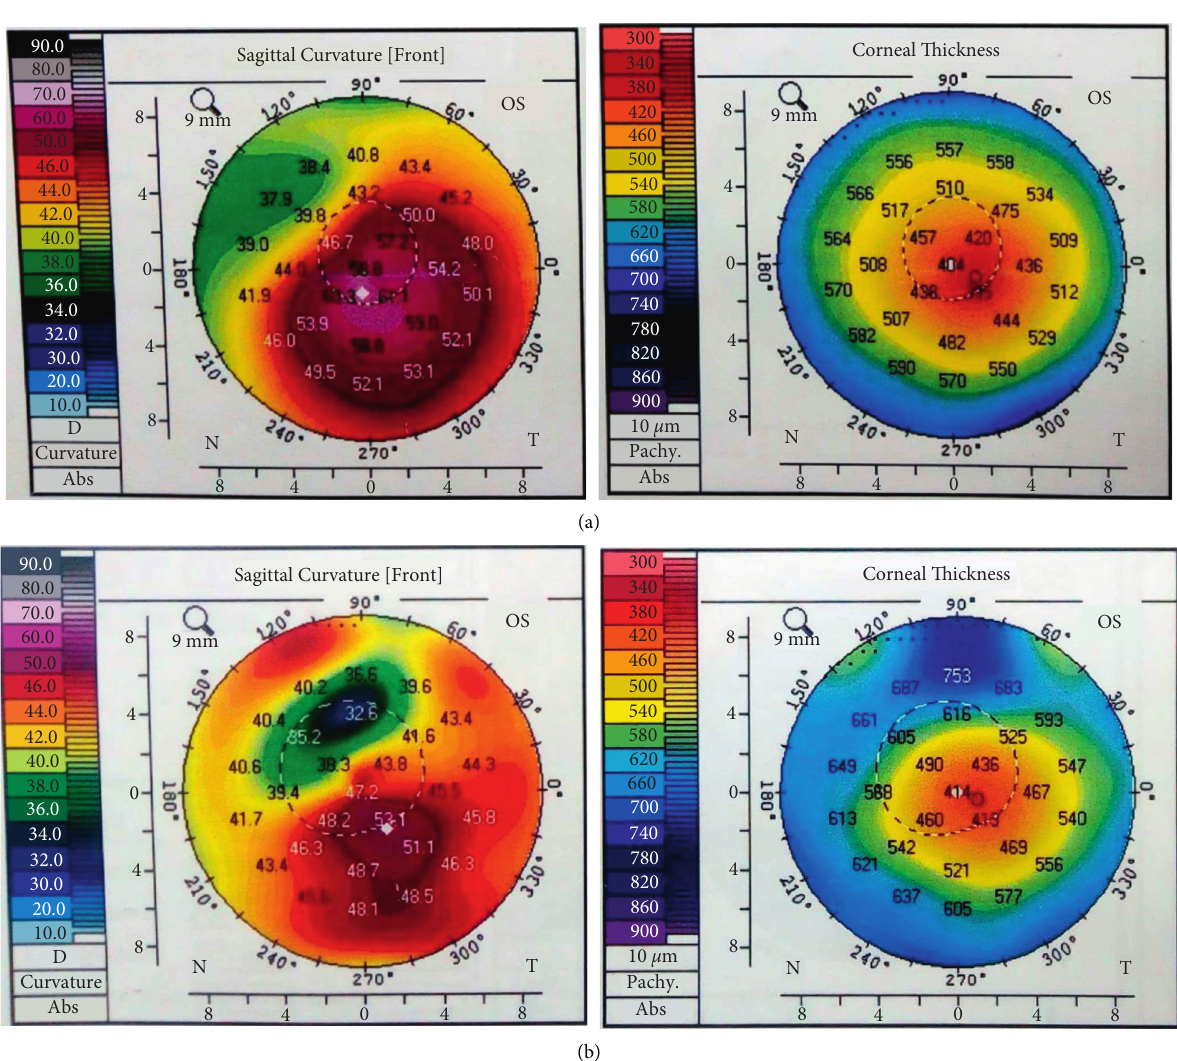
Figure 1: Corneal tomography before (a) and after (b) femtoassisted Myoring